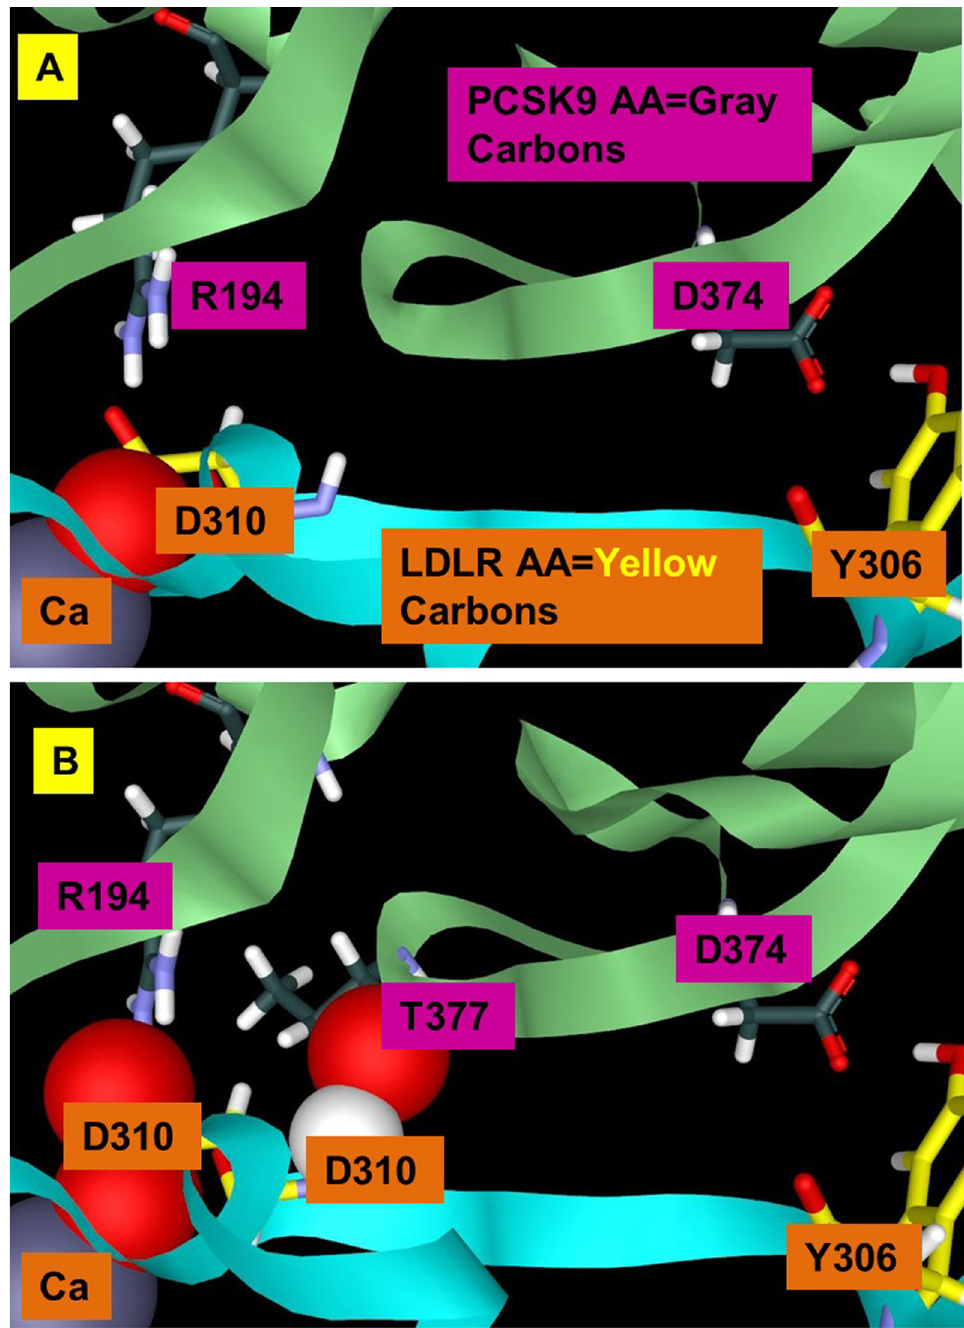
Fig 3. The LDLR D310 interactions with PCKS9. Conversion of one oxygen atom of the carboxyl group (A) from LDLR D310 to VDW representation shows how deeply it penetrates the LDLR Ca 2+ ion as a chelating group. Converting both oxygens of the D310 carboxyl group (B) to VDW representation shows the continuous overlap from the LDLR Ca 2+ ion to R194 of PSKC9. It is noteworthy that the D310 backbone hydrogen interpenetrates the ketone backbone of PCSK9 T377